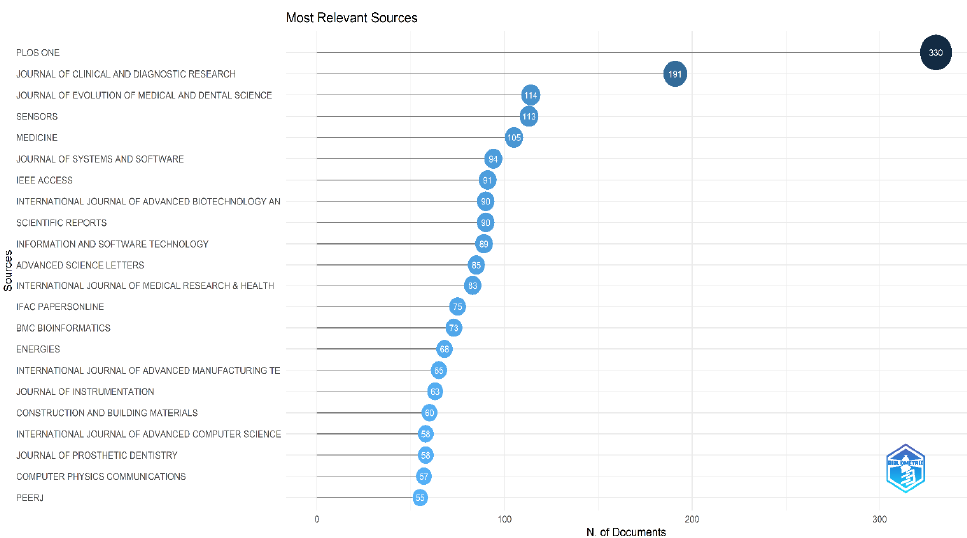
Figure 3. Top 20 most relevant sources of publications with respect to the publication count for the time frame 2016–2018.